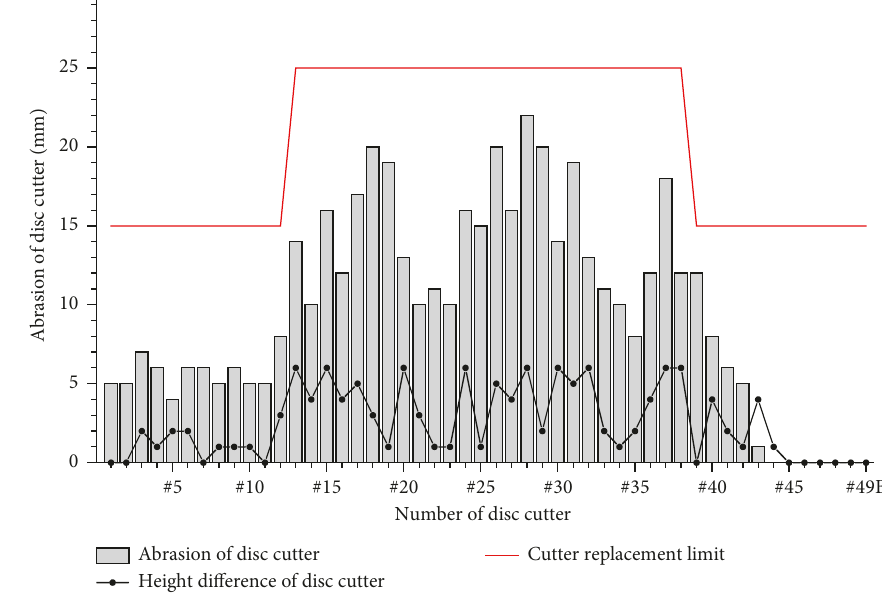
Figure 12: Adjusted disc cutter abrasion and height difference.